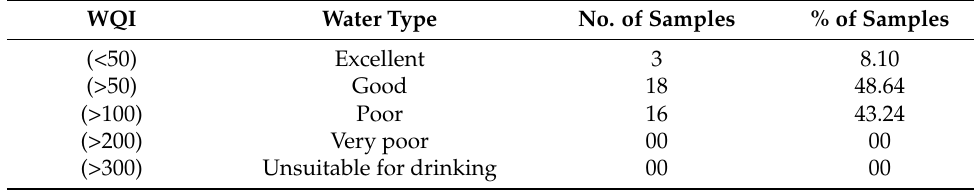
Table 5. Water quality index (WQI) classification of the study